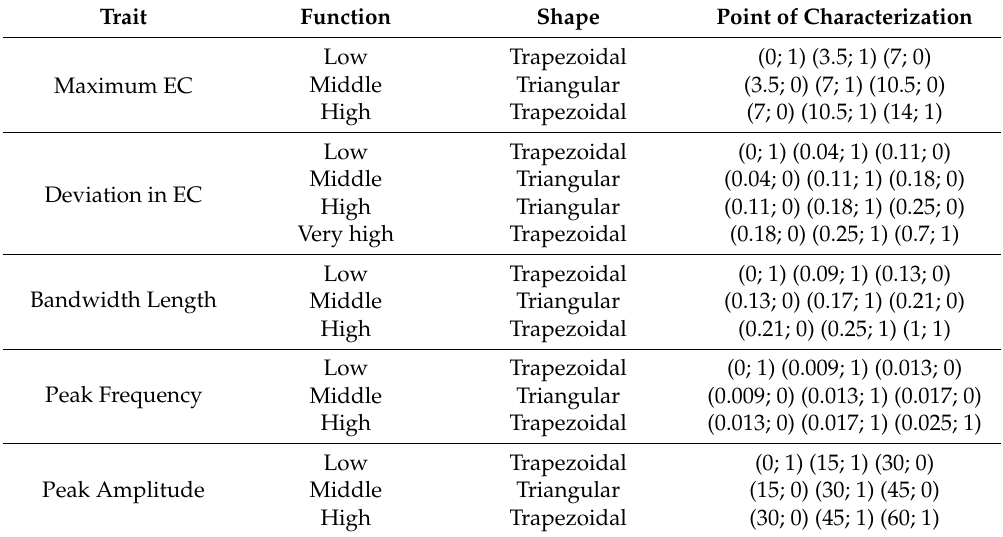
Table 1. Membership functions for the milk electrical conductivity (EC) traits considered in the study. These traits were: (1) Maximum EC; (2) Deviation EC; (3) Bandwidth Length; (4) Peak Frequency and (5) Peak Amplitude.